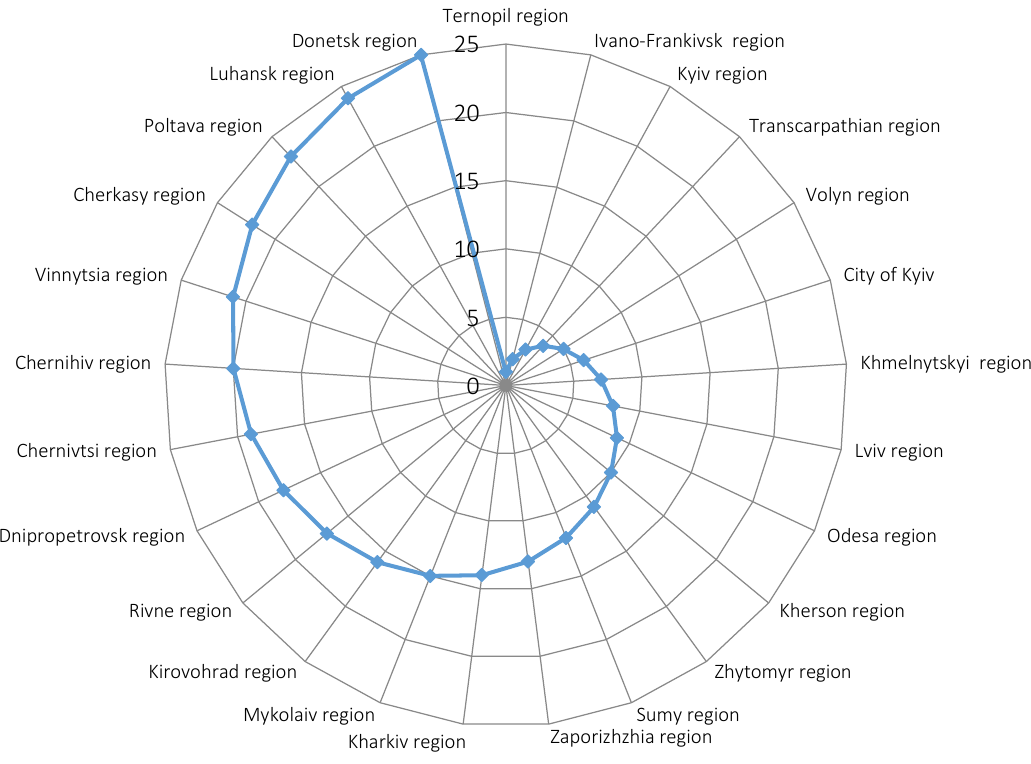
Figure 4. Ranking of the Ukrainian regions in